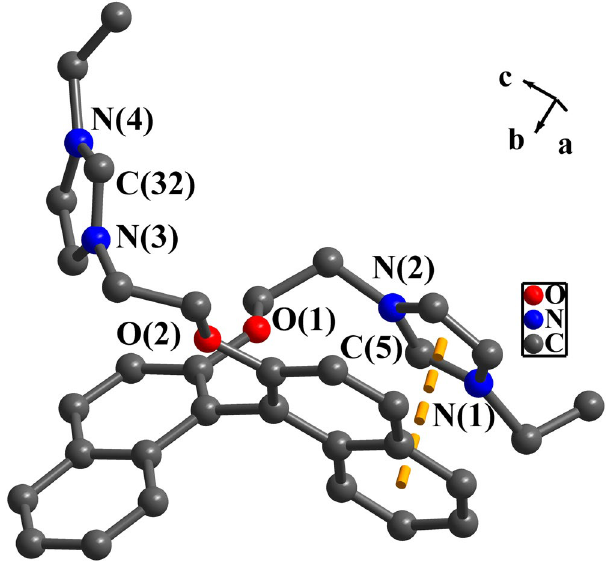
Figure 3. Perspective view of [( S ) -L 2 H 2 ] · ( PF 6 ) 2 . All hydrogen atoms were omitted for clarity. Selected bond lengths (Å) and angles (°): C(5)-N(1) 1.321(6), C(5)-N(2) 1.302(6); N(1)-C(5)-N(2) 108.7(4),